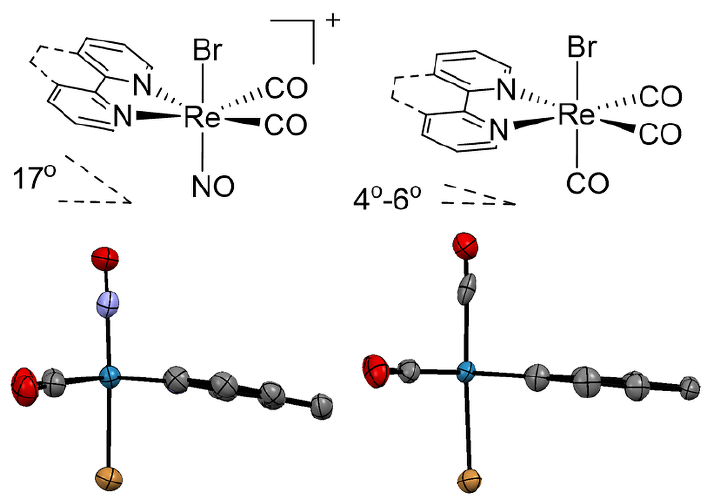
Figure 7. Main structural differences between related diimine fac -[Re(CO) 2 (NO)] 2+ and fac -[Re(CO) 3 ] + species. At the bottom we compare the structures of 2 and a tricarbonyl phen derivative [53] .